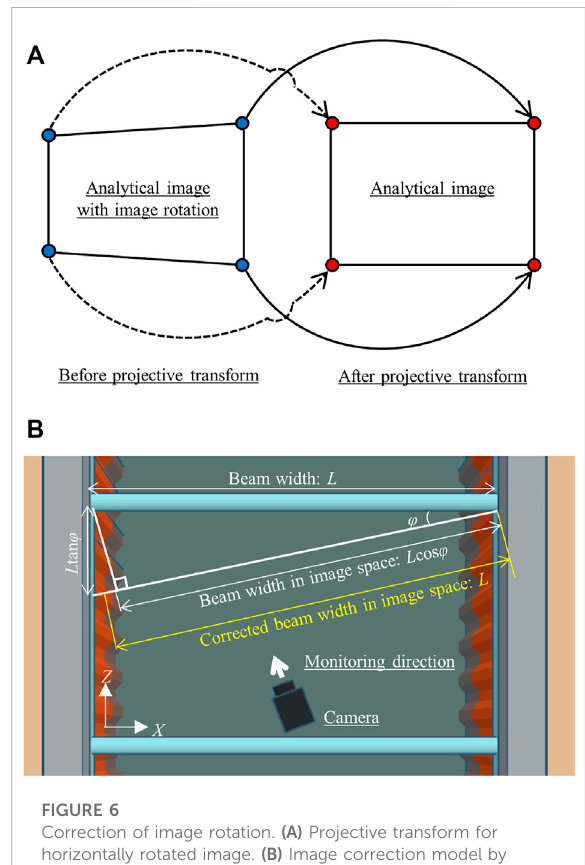
FIGURE 5 Buckling detection by using image analysis with Hough transform. (A) Hough transform theory. (B) Buckling detection model with Hough transform.